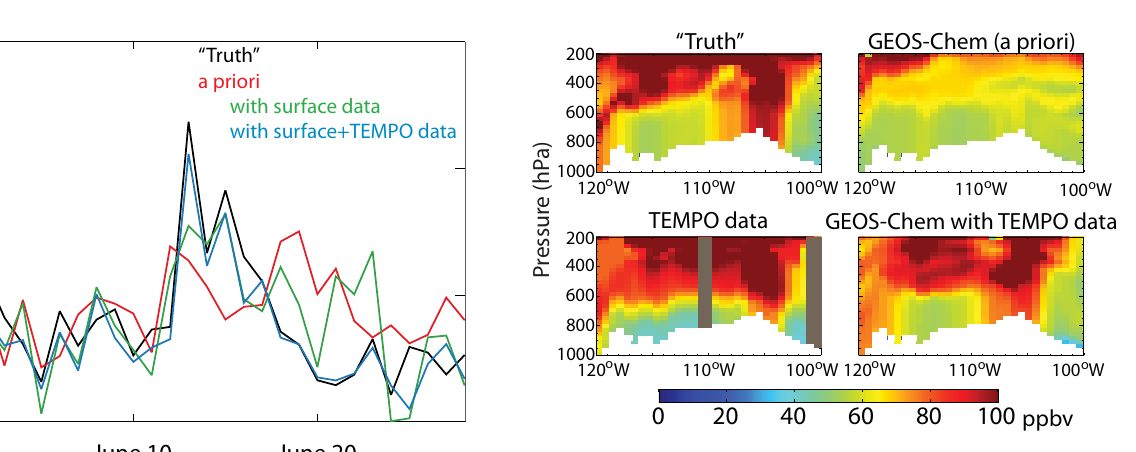
Figure 7. Longitude–altitude cross section of ozone concentrations (36 ◦ N, 21:00, mountain time, on 13 June 2010) associated with the stratospheric intrusion of Fig. 6. The “true” state from the GFDL AM3 model (top left) is compared to the GEOS-Chem model with- out data assimilation (top right) and with assimilation of surface and satellite data (bottom right). The bottom left panel shows syn- thetic TEMPO observations of the “true” state (gray regions indi- cate cloudy scenes) without data assimilation. Orange and red val- ues indicate ozone levels that would lead to exceedances of the cur- rent NAAQS of 75ppbv. Local topography is shown in